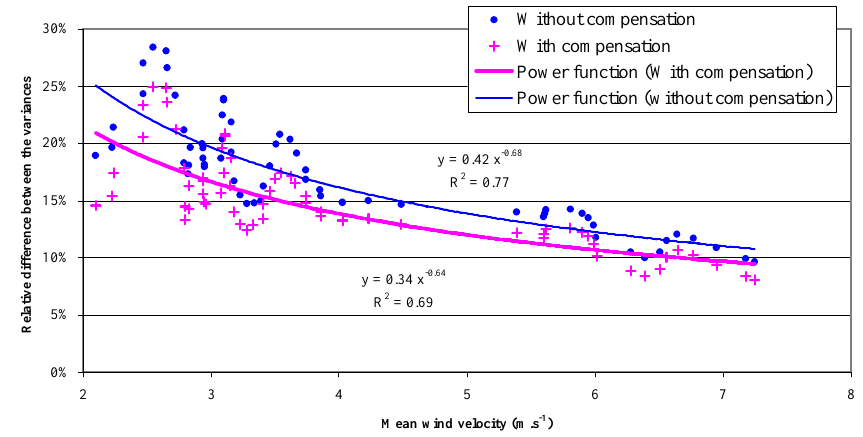
Fig. 9. Relative difference between the wind variances measured by the ultrasonic and a cup anemometer (NKE 25-2). Variation with the Figure 9 mean wind speed and effects of the spectral compensation (Sampling frequency of